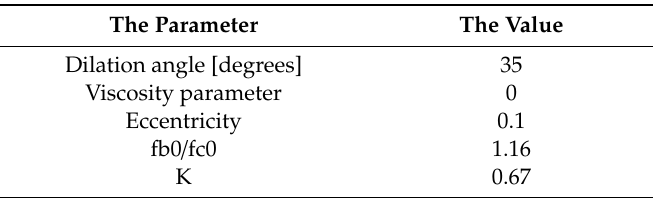
Table 1. CDP model parameters. (Class notes. Finite Element Analysis Lecture#3. Lawrence Tech. University, 2010 [20]. Michal and Andrzej, 2015 [21]).